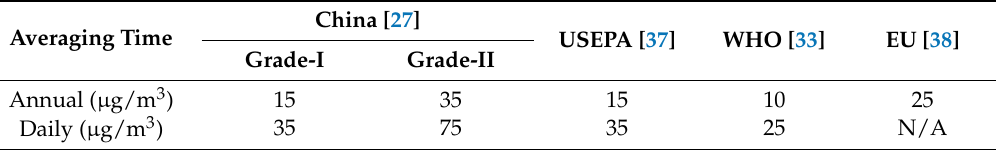
Table 1. Ambient air quality standards of PM 2.5